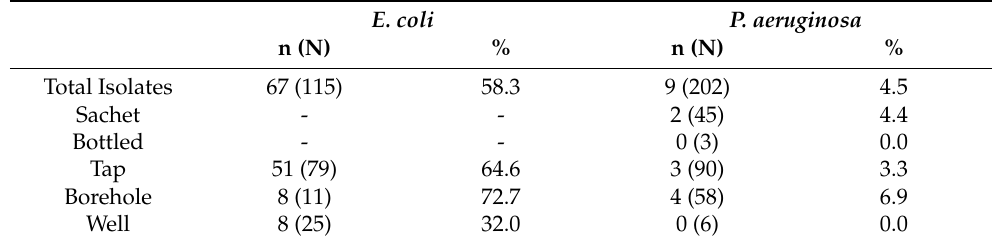
Table 4. Number and proportion of multidrug resistance in E. coli and P. aeruginosa isolates in drinking-water samples tested from Greater Accra region, Ghana (December 2021–March